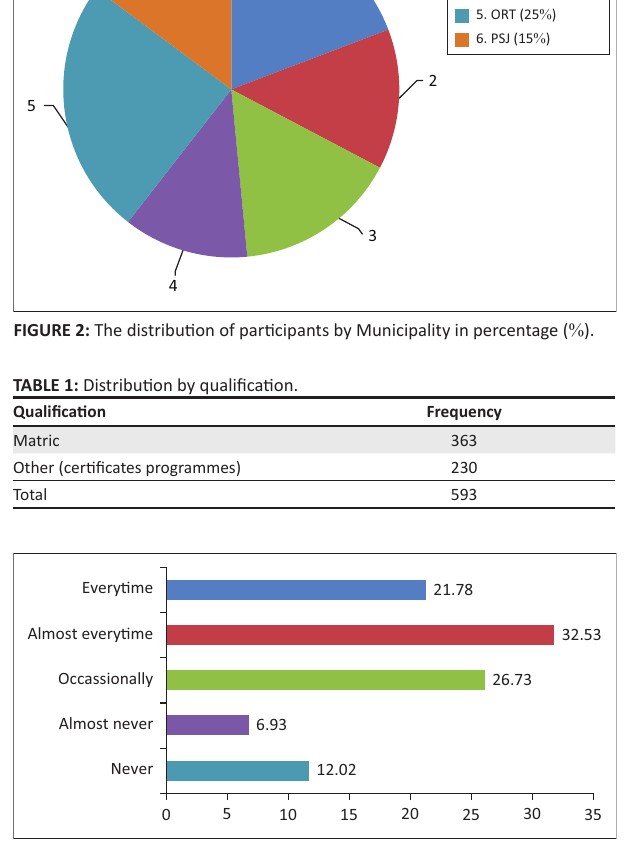
FIGURE 3: Compliance with accepted standards for completing a task in the municipality.